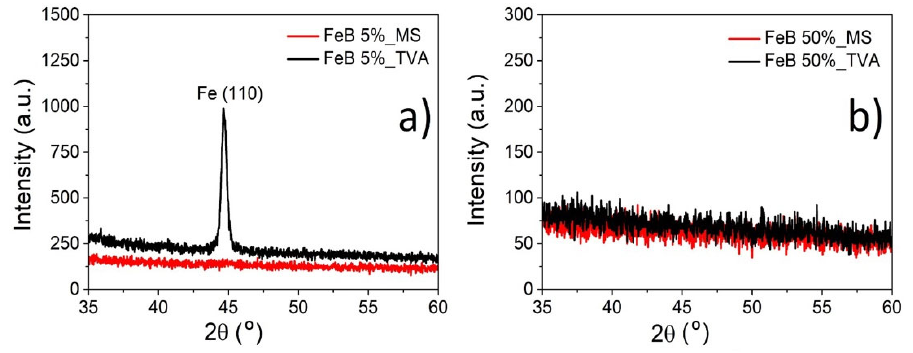
Figure 3. XRD patterns of Fe ‐ B thin films with 5 at. % of B ( a ) and 50 at. % of B ( b ) .